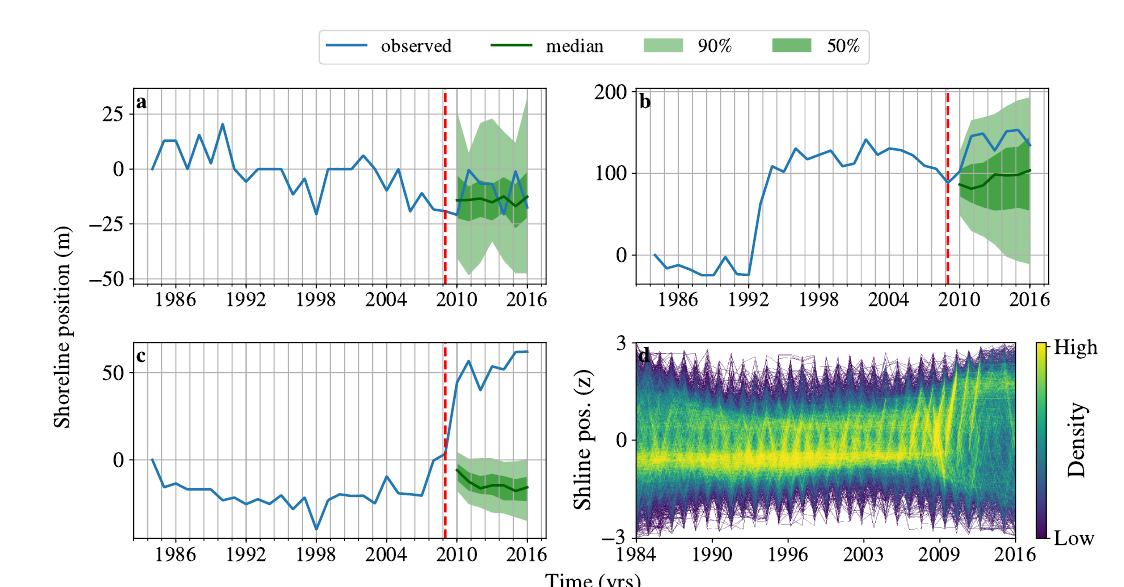
Figure 8. Forecast examples to illustrate typical behavior of the forecast algorithms. ( a ) SimpleFFN forecast for a site located on Cape Lookout (34.9572 ◦ N; 76.1767 ◦ W), North Carolina, USA. This example shows how probabilistic forecasts are typically reliable and predict the right trend, but lack (some) sharpness. ( b ) ETS forecast for a transect site on Peck’s beach (39.2672 ◦ N; − 74.5840 ◦ W), New Jersey, USA. The graph shows how classical models are able to deal with shocks in shoreline trajectories, especially when observations lie more distantly in the past. ( c ) ARIMA forecast for a site located, next to a groyne, on the coast of Mar del Plata, Argentina (37.9658 ◦ S; 57.5391 ◦ W). ( d ) Count-density plot of standarized time-series which compromise per algorithm the 5% worst forecasts in terms of